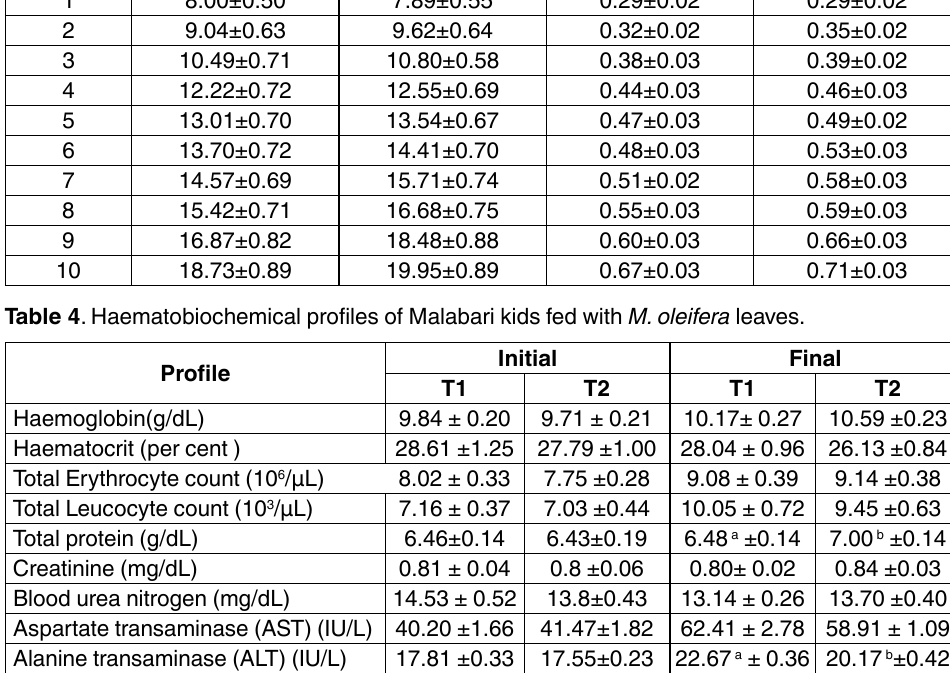
table 3 . Body weight (kg) and daily dry matter intake (kg) in control and experimental animals Fortnight